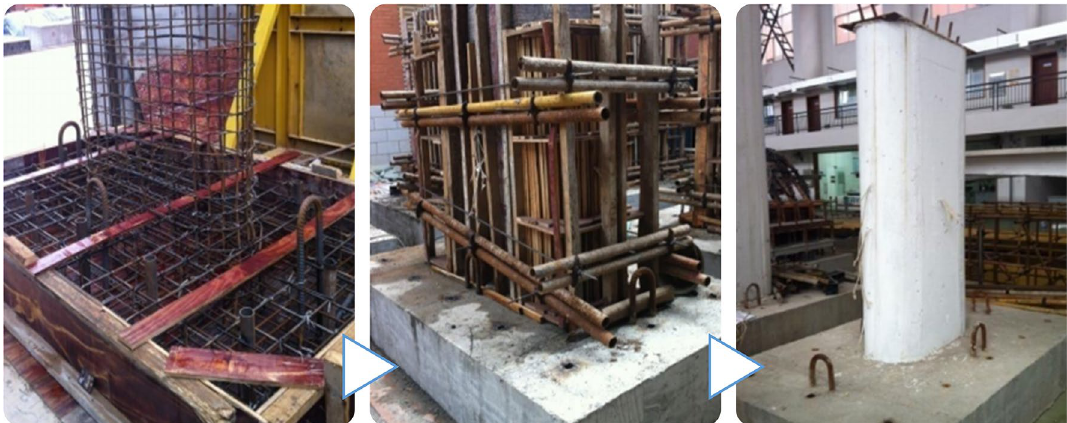
Figure 4. Drawings for the RERSCSS concrete piers used in the HSRB specimen (unit: cm). Top: specimen reinforcement drawing; bottom: specimen construction drawing.